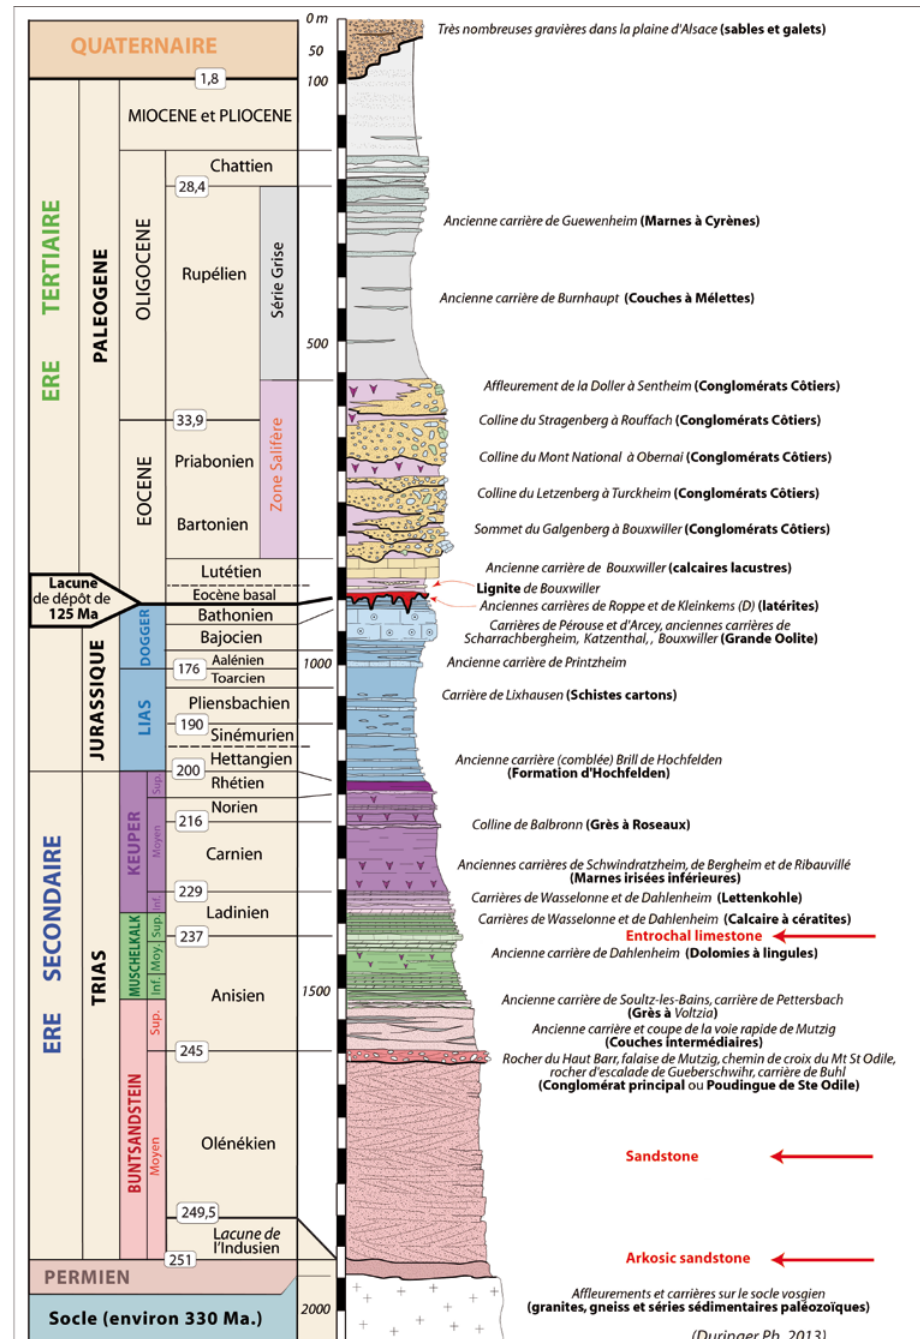
Figure 11. General stratigraphic sequence of the “Alsace” region. The thickness of the layers is to scale except for the highly variable Permian layers and deposits at the base of the sequence that group a number of rock types (plutonic, volcanic, subvolcanic, metamorphic and sedimentary) (Ph. Duringer, IPG-EOST). The rocks used for the tools written in